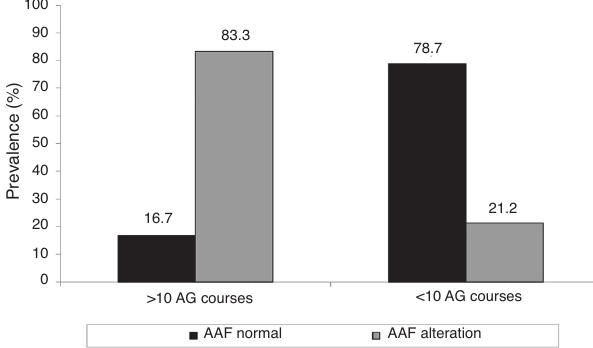
Figure 4 Association between number of AG cycles and HFA alteration. AG, aminoglycosides; HFA, high frequency audiome- try. courses of intravenous AG was associated with a higher prevalence of HFA alterations (Fig.